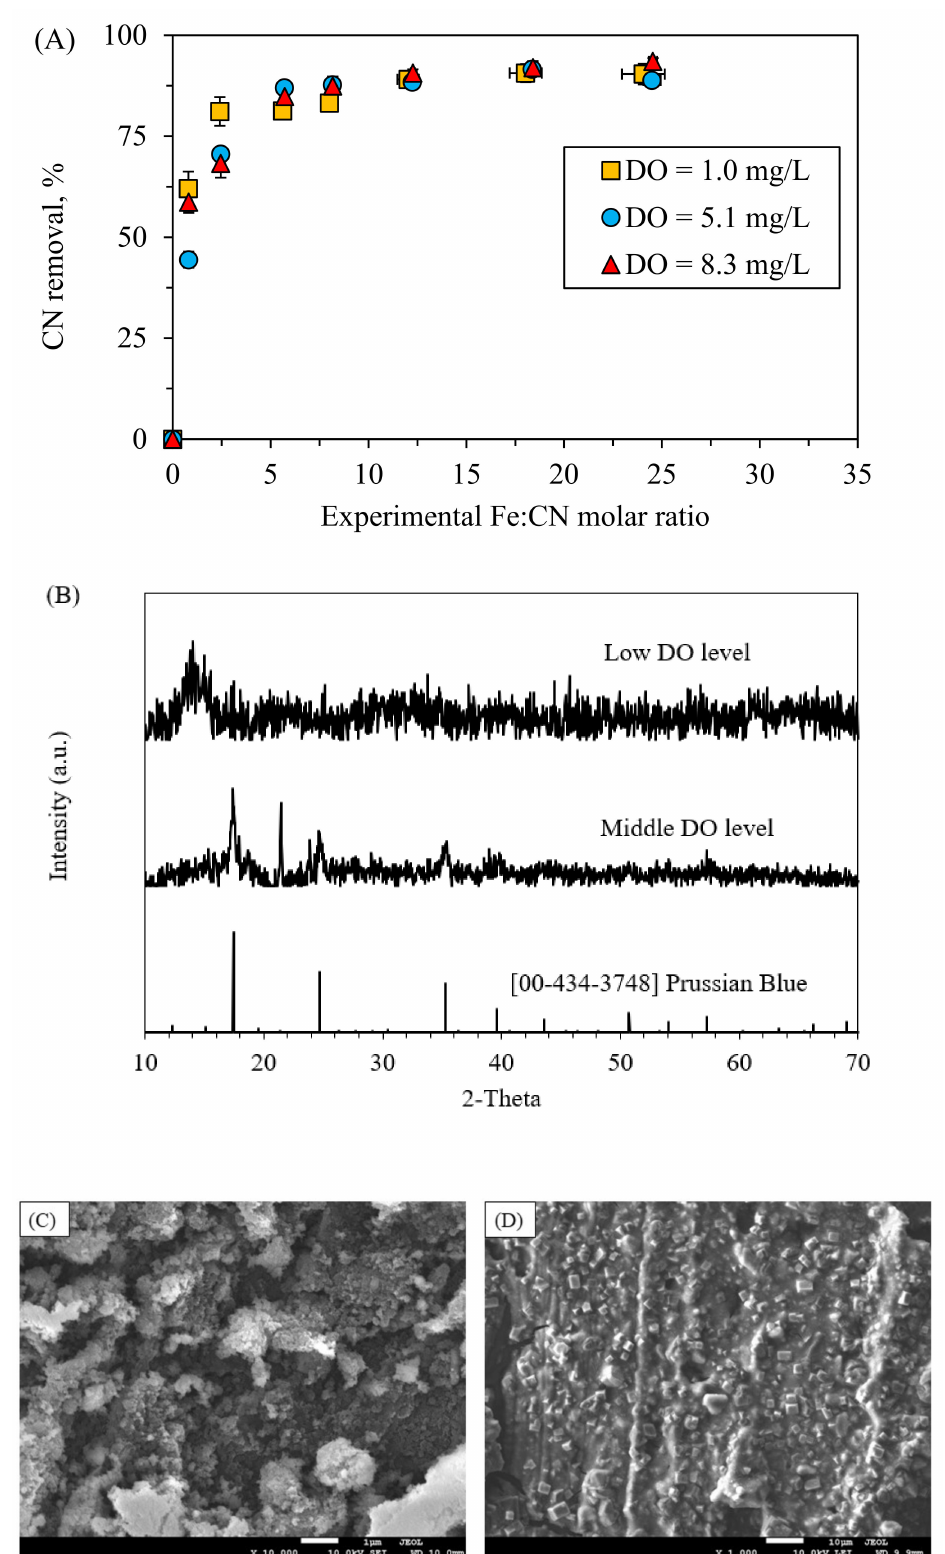
Figure 7. ( A ) CN − removal as a function of the experimental Fe:CN − molar ratio for various initial DO levels; ( B ) XRD powder patterns and ( C ) SEM observations of the precipitates produced at Fe:CN − molar ratio of 0.8, ( C ) middle and ( D ) low DO levels. Initial CN − concentration of 10 mg/L. Control pH of 7. Current intensity of 1